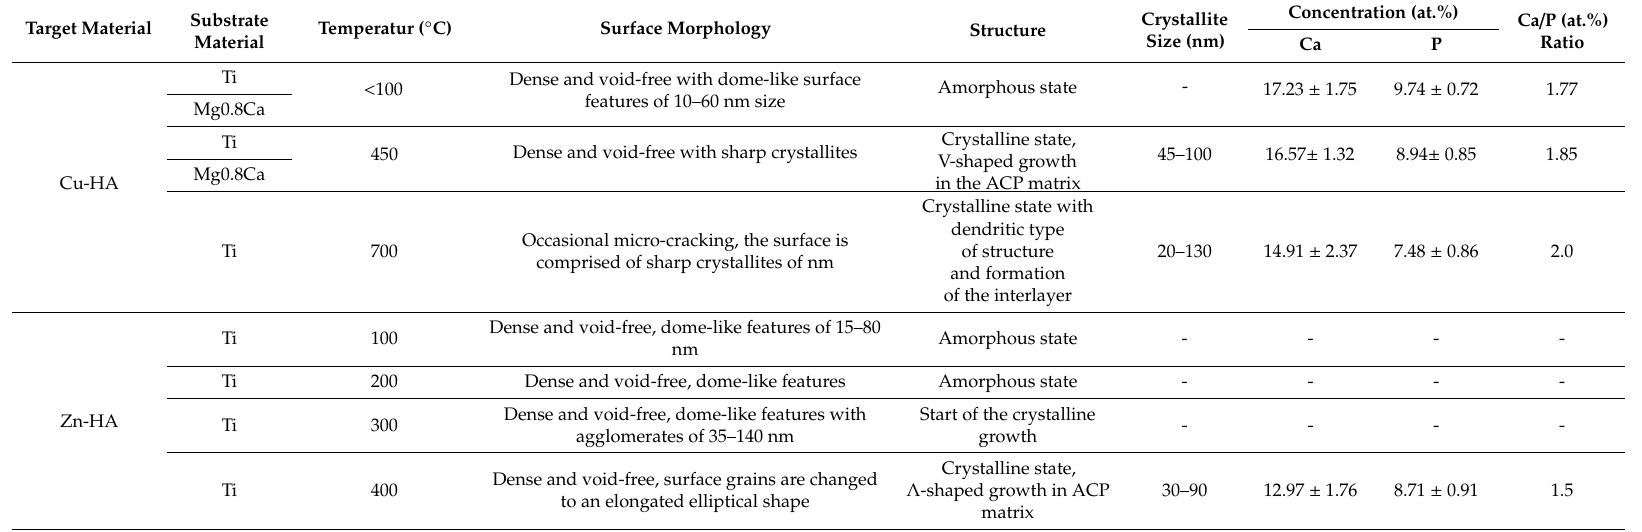
Table 3. Comparison table of deposited